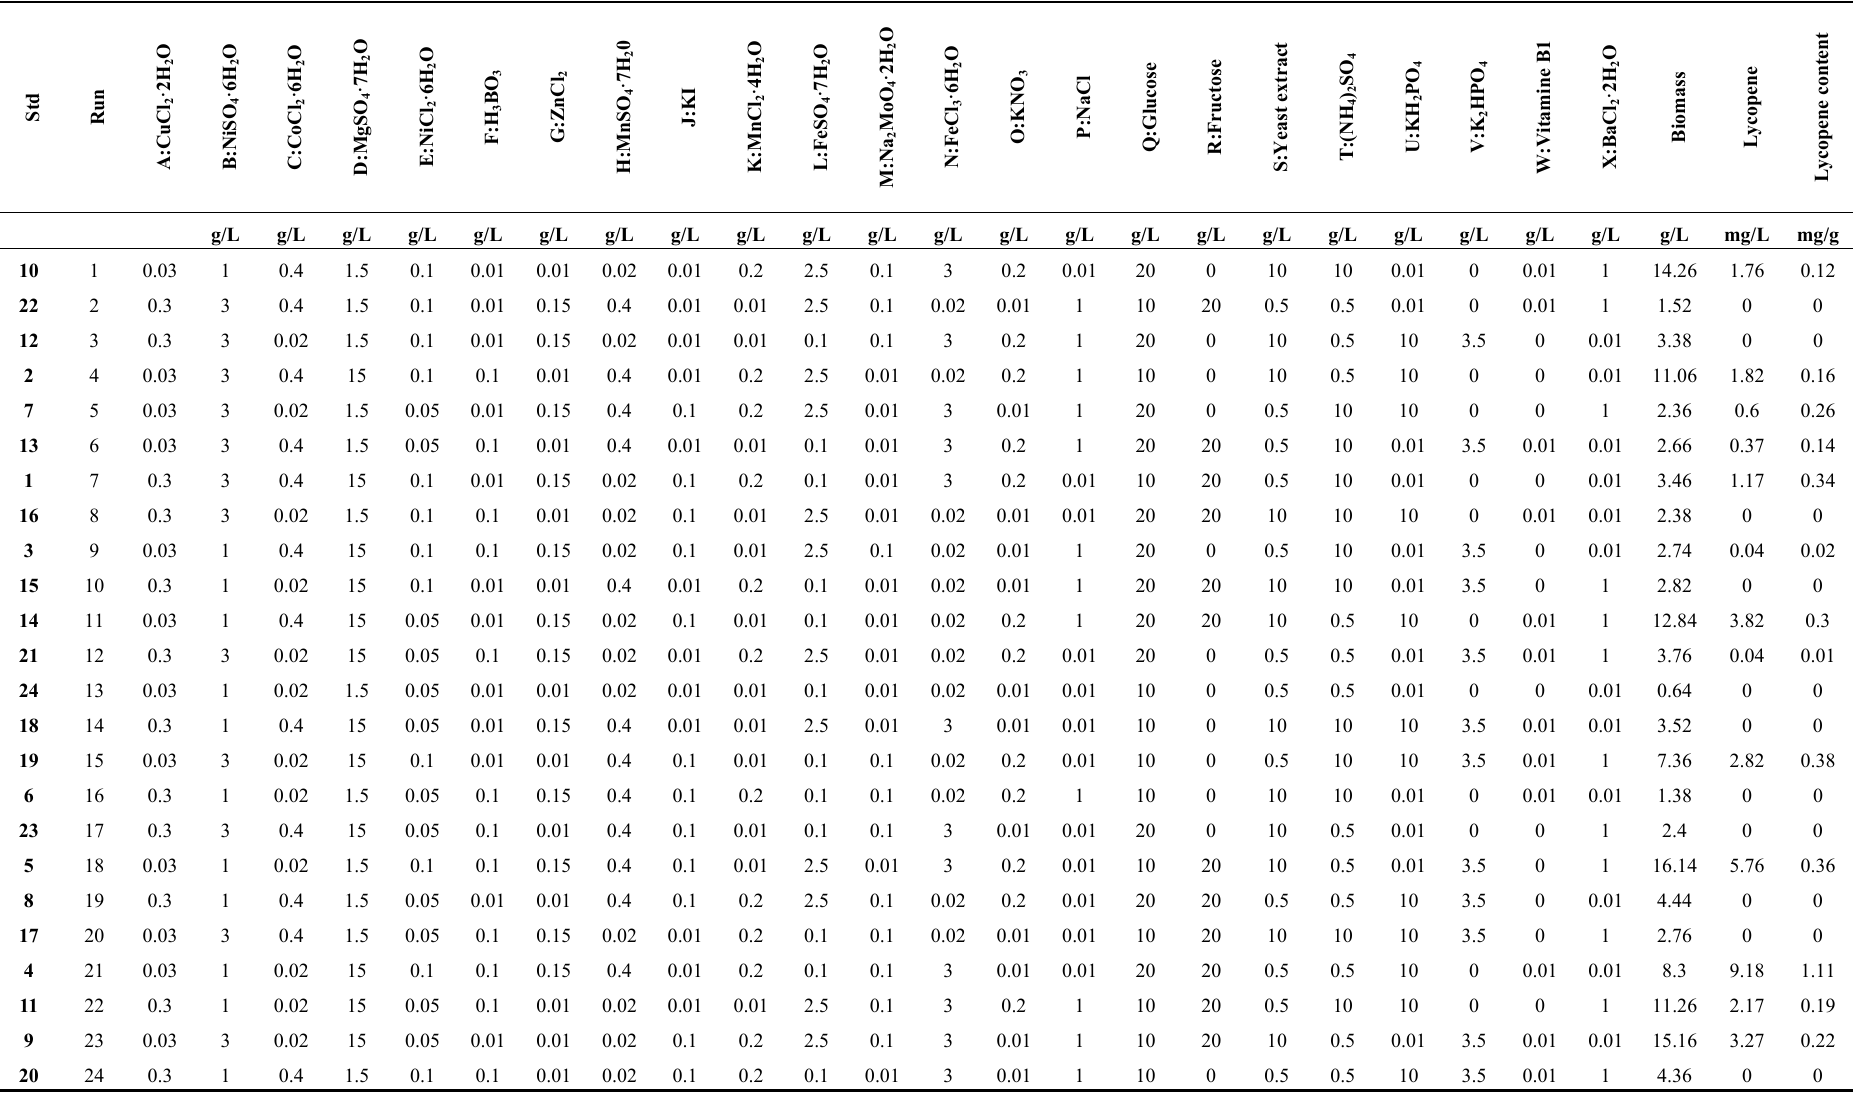
Table 1. Matrix of Plackett-Burman screening of medium components selected independently from the